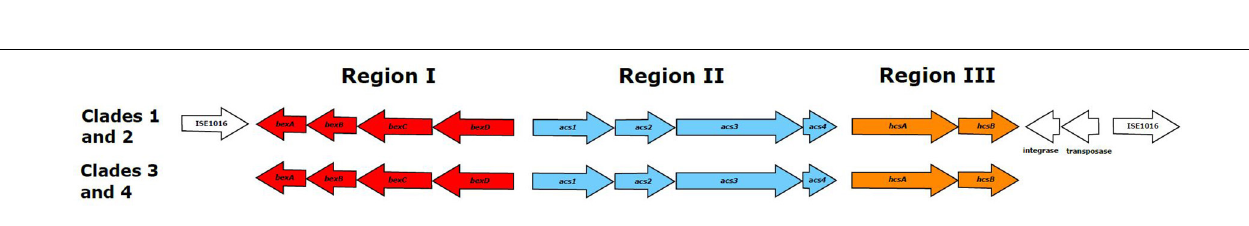
Frontiers in Microbiology |